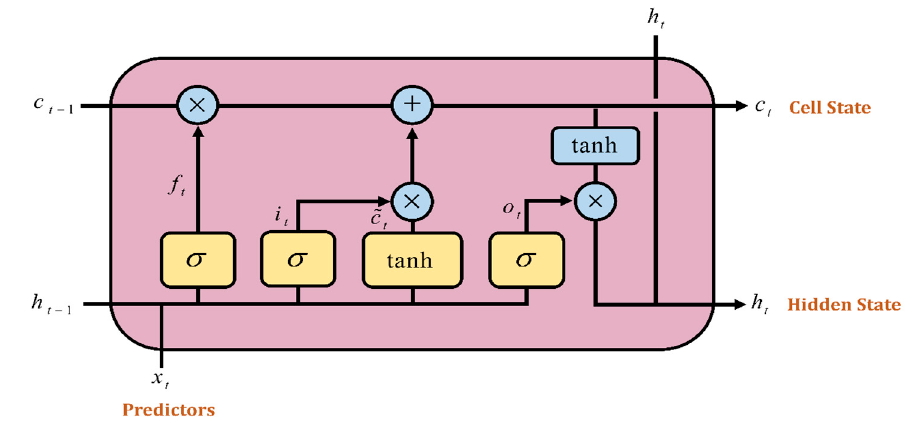
Figure 3. Long Short-Term Memory (LSTM) gates.